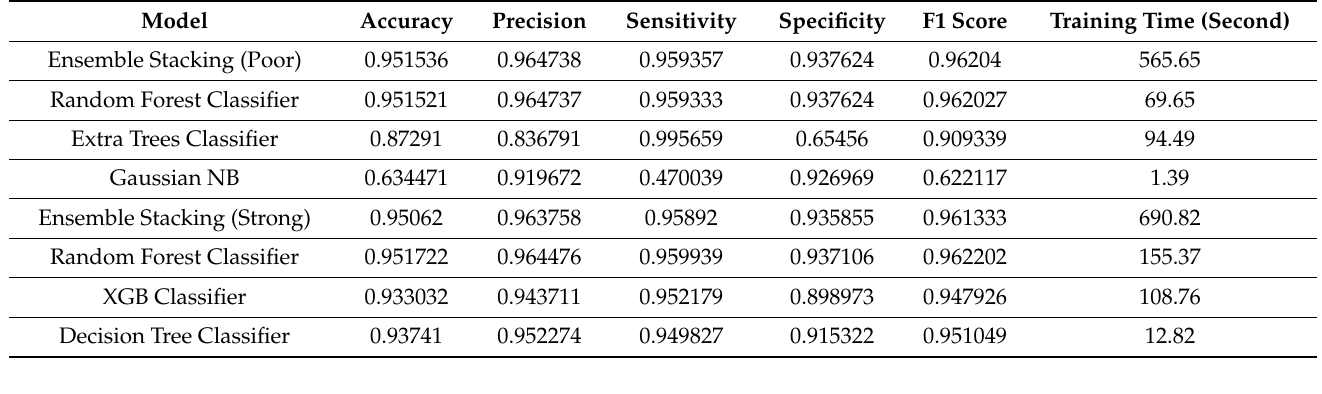
Table 7. Cyberattack detection using ensemble stacking for the UNSW dataset.